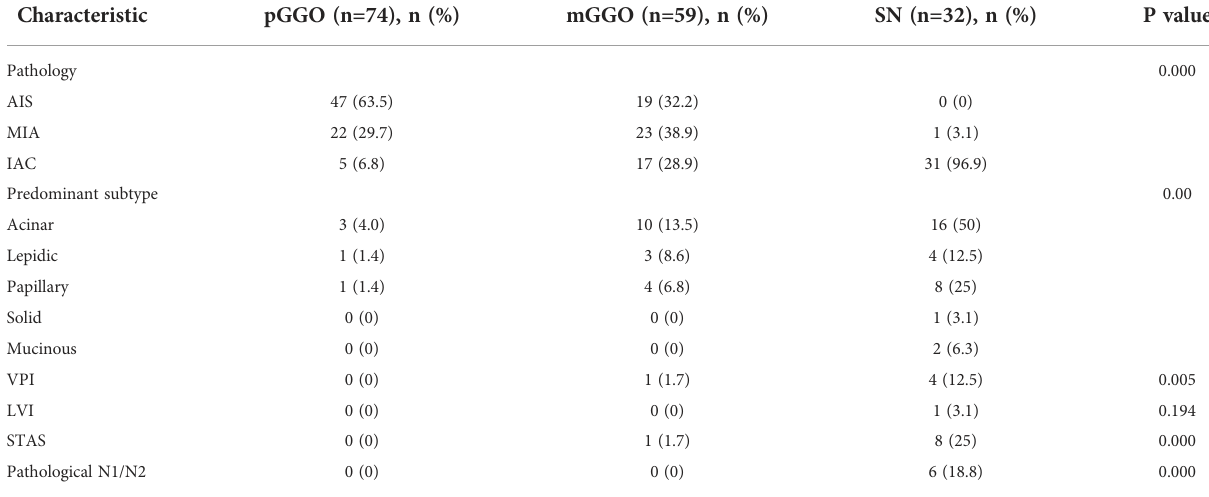
TABLE 3 Pathological analysis of Lesion.